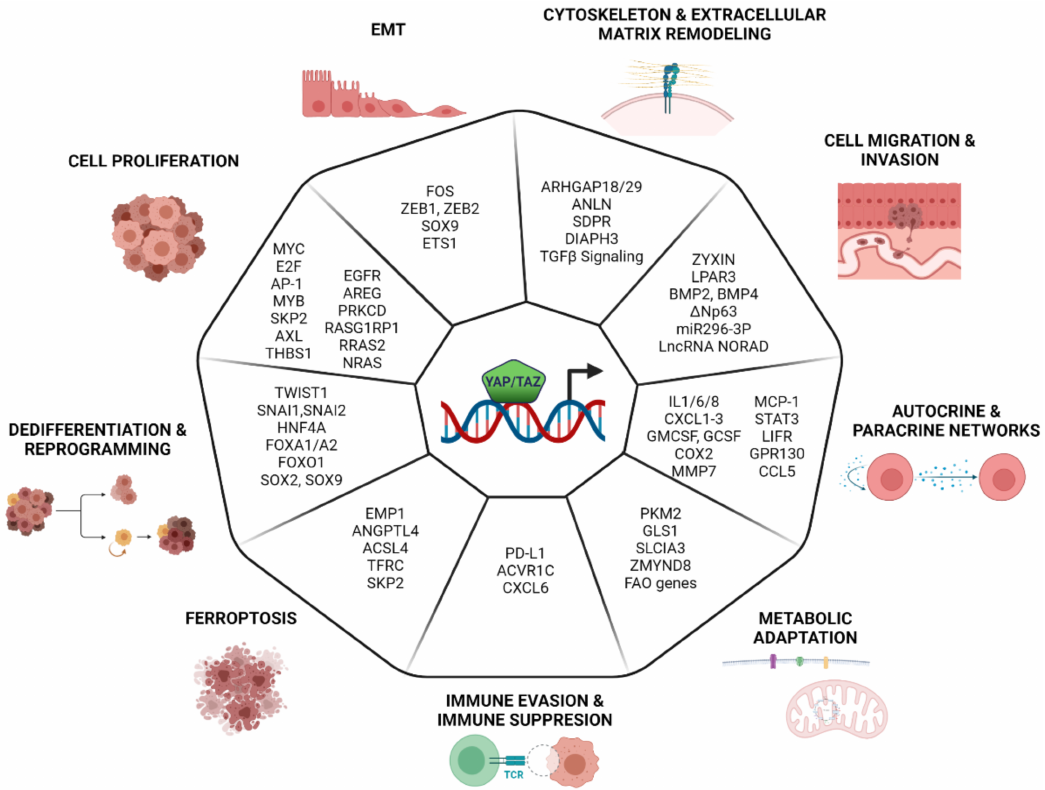
Figure 2. Cancer cell programs controlled by YAP and TAZ. This figure summarizes the biological processes controlled by YAP and TAZ in cancer cells. For each program, key downstream genes/pathways are reported according to their documented role as effectors of the indicated biological program. For the sake of simplicity, genes are all represented as regulated by YAP/YAZ, but it is implied that in many cases, the expression of these genes depends on the integration with other transcription factors, as detailed in the text. Created with BioRender.com. (https://help.biorender.com/en/articles/3619405-how-do-i-cite-biorender, accessed on 23 July